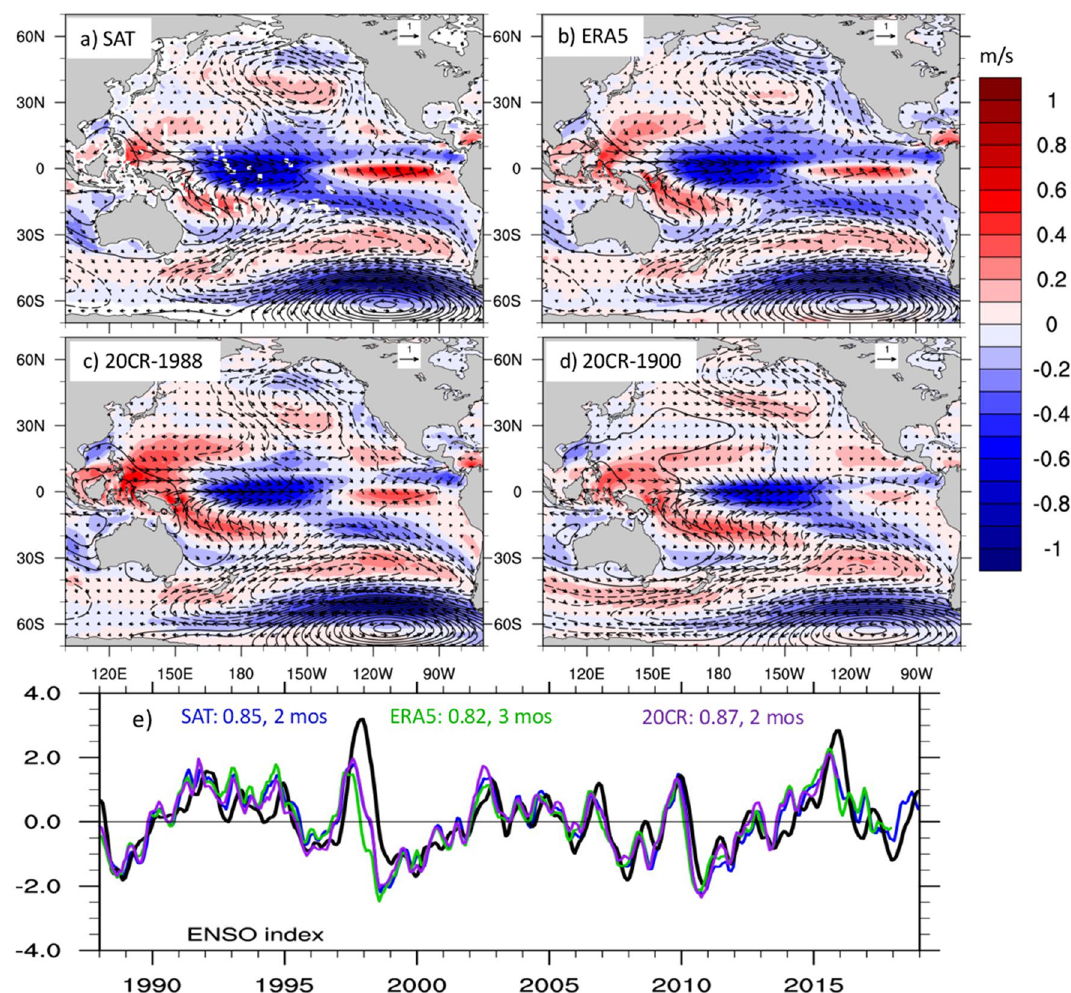
Figure 1. Pacific patterns of wind speed variability and relationship with ENSO. Leading EOF of wind speed for ( a ) Merged satellite winds (variance explained 14.3%), ( b ) ERA5 (12.8%), ( c ) 20CRv3 during 1988–2015 (12.8%), and ( d ) 20CRv3 over 1900–2015 (9%) over the Pacific basin (70° S–70° N, 100° E–70° W). Black contours show the regression of SLP anomalies (in Pa) upon the EOFs’ time series, or Principal Components (PCs). Dashed contours indicate negative values. Arrows show the vector winds regressed on the leading PCs of each wind speed product. SLP and winds from ERA5 are used in ( a ) and ( b ), while SLP and winds from 20CRv3 are used in ( c ) and ( d ). Vector winds are in m/s. ( e ) Comparison between the canonical ENSO index (black, see “Methods”), and the PCs of the leading wind speed EOFs, as indicated by the different colors. Numbers on the top indicate the maximum correlation and the wind speed lead time at which the maximum correlation is achieved for each data